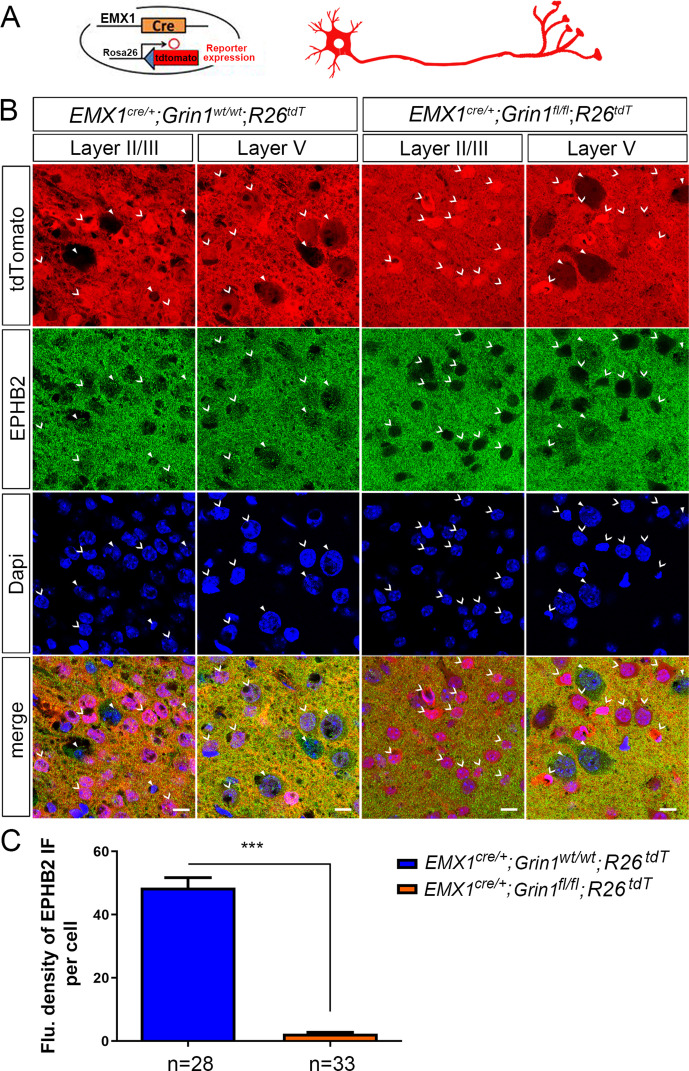
The cell membrane expression of EPHB2 was absent in Emx1cre/+; Grin1fl/fl; Rosa26fs-tdTomato positive cells.(A) We crossed Emx1cre/+; Grin1fl/fl mice with Cre-reporter Rosa26fs-tdTomato mice to produce GluN1 knockout cells labeled with red fluorescence. (B) 12 µm coronal brain sections from P8 Emx1cre/+; Grin1wt/wt; Rosa26fs-tdTomato and Emx1cre/+; Grin1fl/fl; Rosa26fs-tdTomato mice of the same litter. Immunostaining of EPHB2 was done in all brain sections. Broad arrowheads pointed the cells with Cre recombination. Triangle arrowheads pointed to cells with Cre recombination. V shaped arrowheads pointed to cells without Cre recombination. In control Emx1cre/+; Grin1wt/wt; Rosa26fs-tdTomato mice, EPHB2 signals were detected on both Cre recombination and non-Cre recombination cells. However, in Emx1cre/+; Grin1fl/fl; Rosa26fs-tdTomato mice, EPHB2 signals were only detected on non-Cre recombination cells, but absent on Cre recombination cells with deletion of GluN1. (C) Quantification of fluorescence density of EPHB2 immunostaining for each cell. Compared to control (Emx1cre/+; Grin1wt/wt; Rosa26fs-tdTomato mice), the protein expression of EPHB2 in Cre recombination cells in Emx1cre/+; Grin1fl/fl; Rosa26fs-tdTomato mice was dramatically decreased. p<0.0001. Scale bar: 10 μm for all images in B. R26tdT: Rosa26fs-tdTomato.